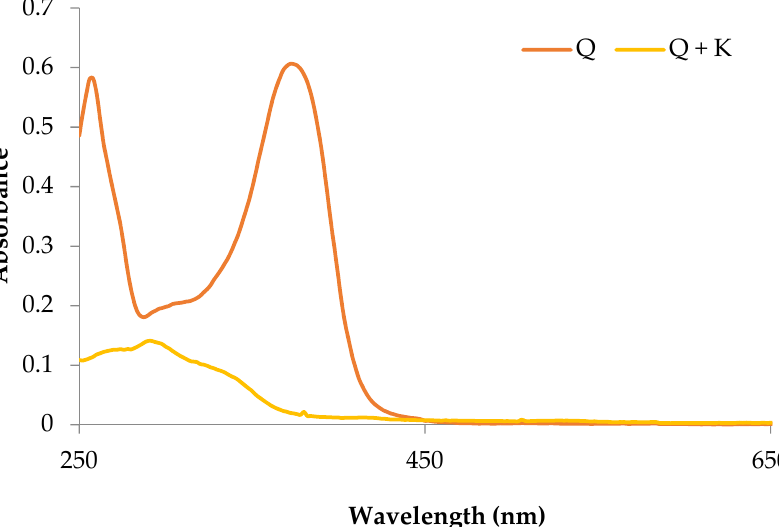
Figure 2. UV-vis spectrum of potassium quercetin derivative and quercetin. Q—quercetin methanol solution with a concentration of 0.1 mg/mL. Q + K—methanolic solution of potassium quercetin derivative with a concentration of 0.1 mg/mL. Table 1. Antioxidant activity against ABTS and DPPH of the potassium quercetin derivative, ex- pressed as a percentage of the standard substance activity. Lowercase letters indicate significant differences between the means at respective measurement according to t-Student’s test ( p = 0.05).